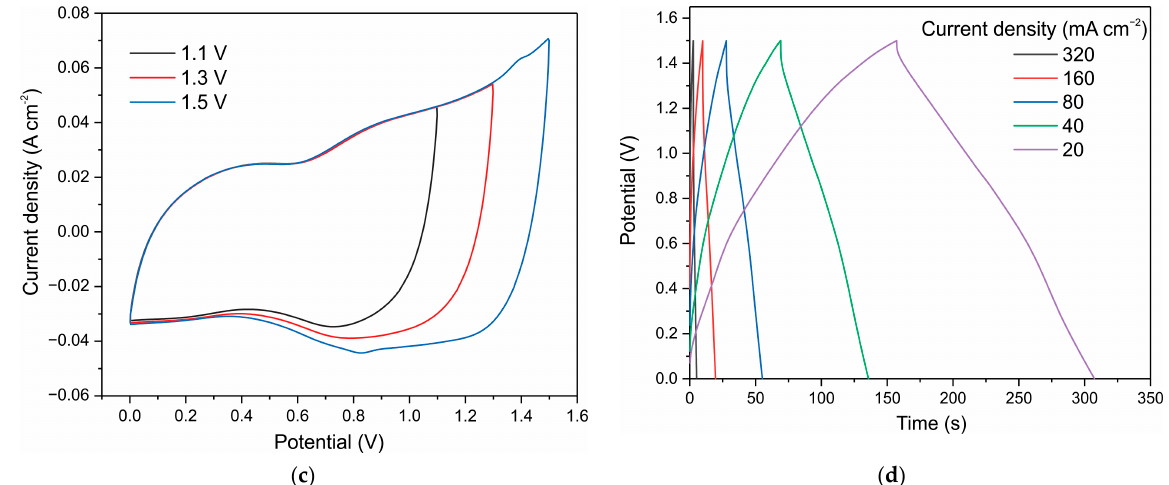
Figure 10. CV curves at 0.008 V s − 1 of the positive (reduced Co 3 O 4 NPs–NF) and negative (AC–NF) electrodes ( a ); CV curves of Co 3 O 4 NPs–AC capacitor at different scan rates of 8–60 mV s − 1 ( b ); CV curves of the capacitor at different voltage windows, and 8 mV s − 1 scan rate ( c ); and GCD curves of the capacitor at different current densities ( d ).